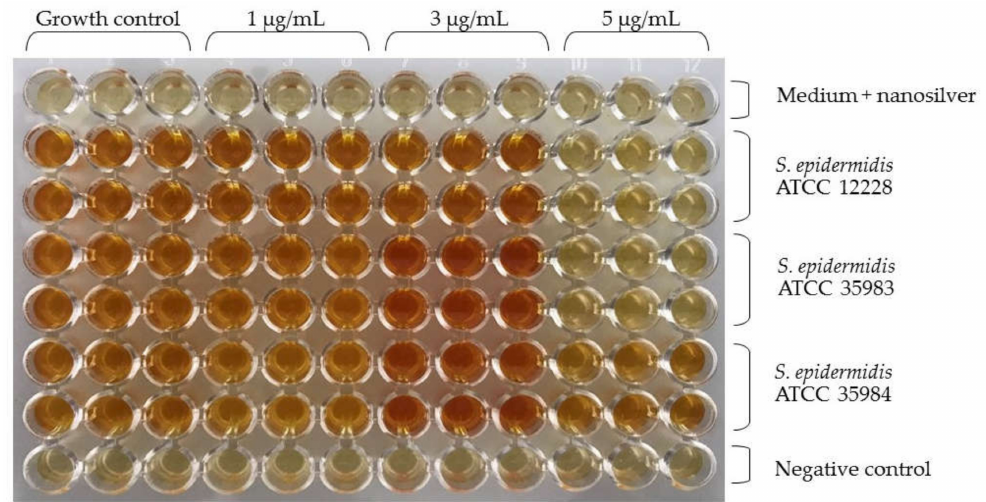
Figure 6. Color change in the microtiter plate as an indicator of decreased S. epidermidis viability. In the upper part there is a description for nanosilver concentrations in triplicate (1 µ g/mL, 3 µ g/mL, 5 µ g/mL). The side part provides a description for the S. epidermidis strains tested in duplicate.